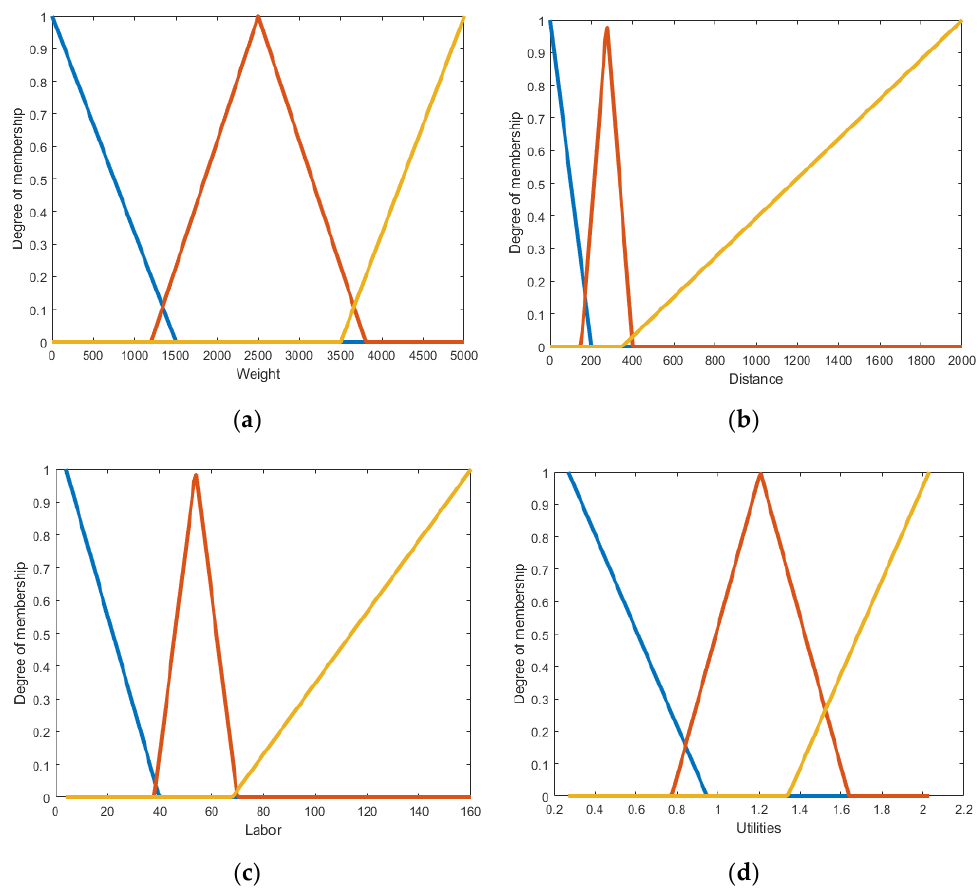
Figure 5. Membership functions of input parameters — ( a ) weight; ( b ) distance; ( c ) labor; ( d ) utilities. Fuzzy sets colour key: blue — low; red — medium; yellow — high; and purple line — very high.